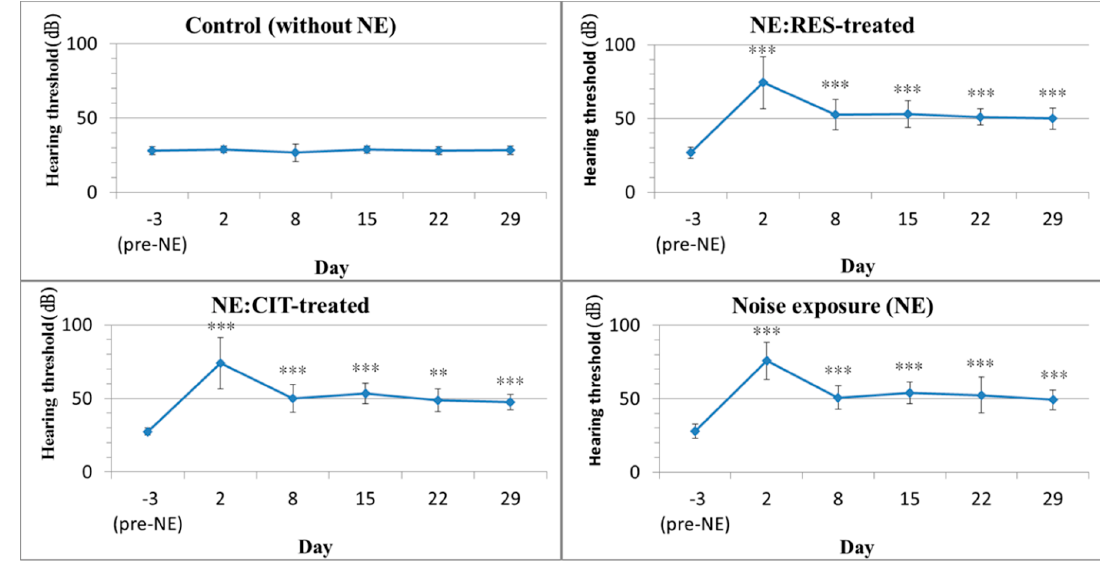
Figure 1. The four graphs depict the effects of noise exposure on the hearing threshold. Mean ABR thresholds in response to click stimuli are displayed for the control group (n = 6; upper left), the RES-treated group (n = 6; upper right), the CIT-treated group (n = 6; lower left), and the NE group (n = 6; lower right) before and after exposure to narrowband noise (8 kHz, 116 dB) for 3.5 h. After noise exposure, a permanent hearing loss of approximately 50 dB SPL was seen in the NE and the drug-treated groups during the following 4 weeks. * p < 0.05, ** p < 0.01 and *** p < 0.001 versus the control group. (ABR: auditory brainstem response, CIT: citalopram, RES: resveratrol, NE: noise